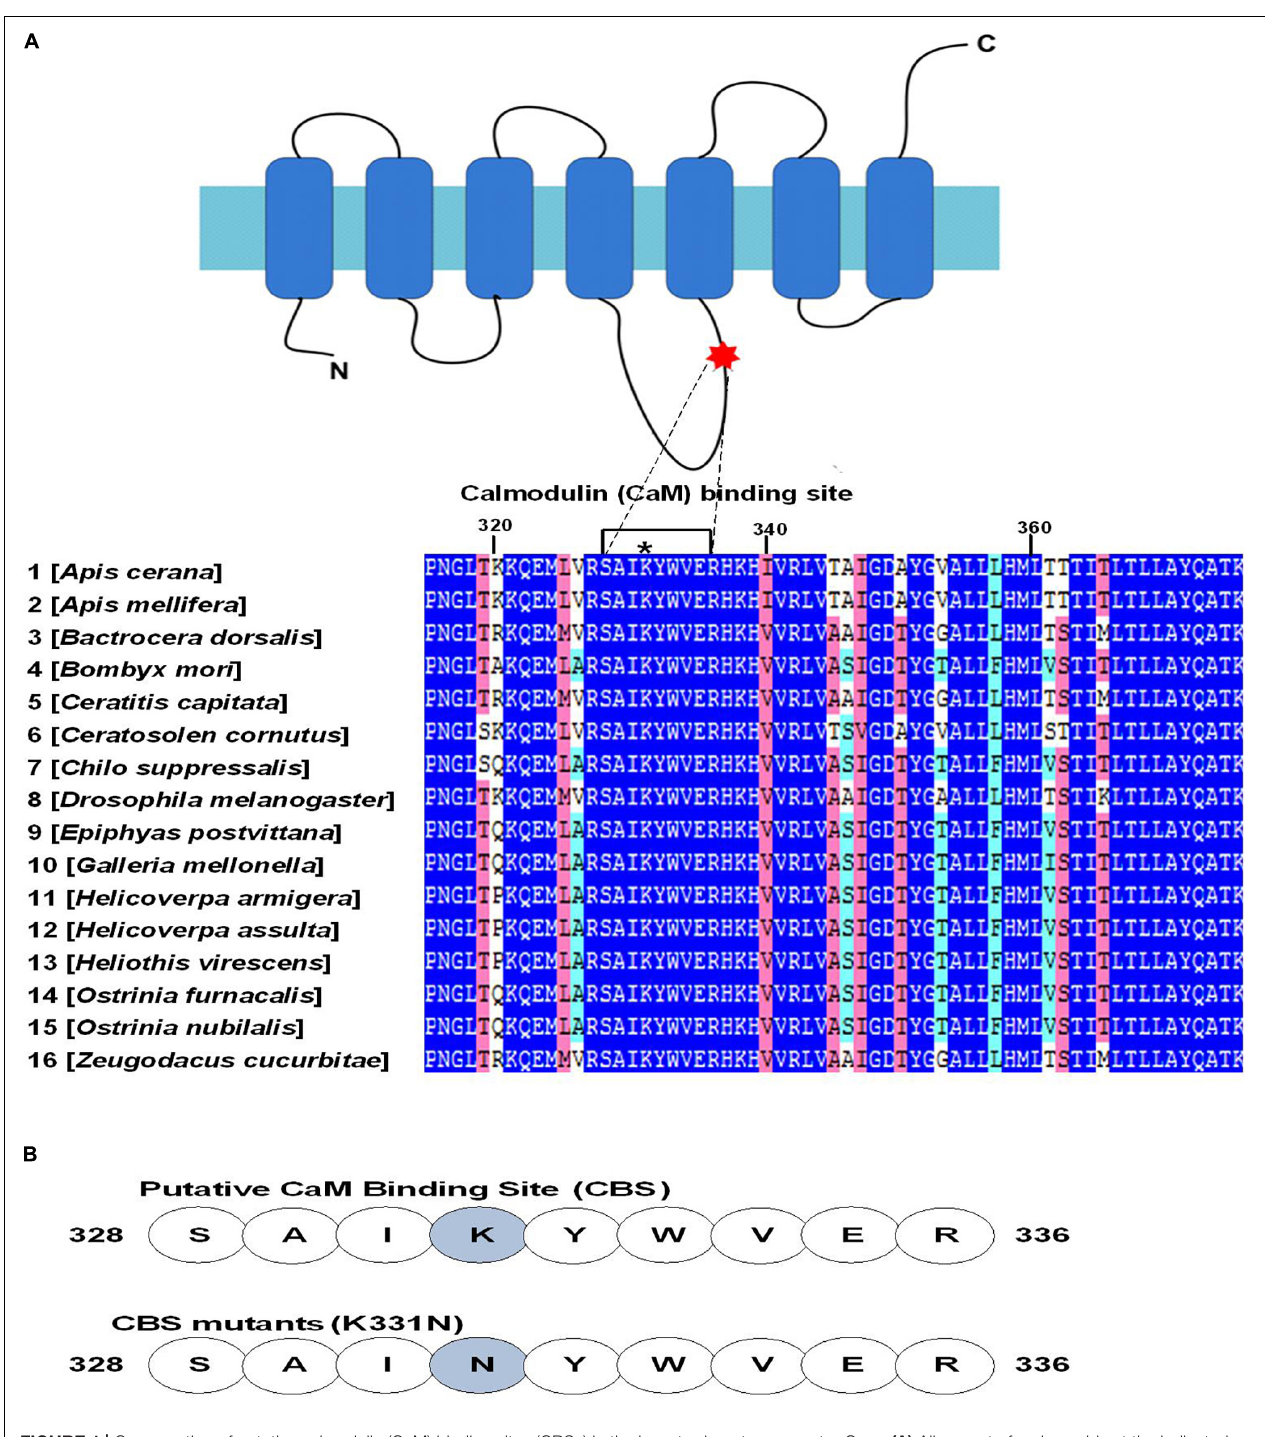
Frontiers in Ecology and Evolution |